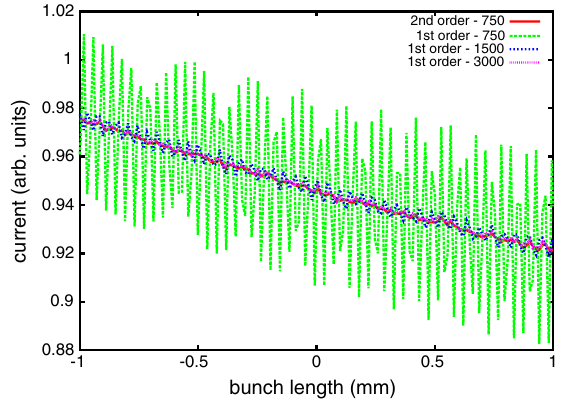
FIG. 18. A section of the current profile of the beam after the emission using the second-order emission model and the first- order emission model with different numbers of emission